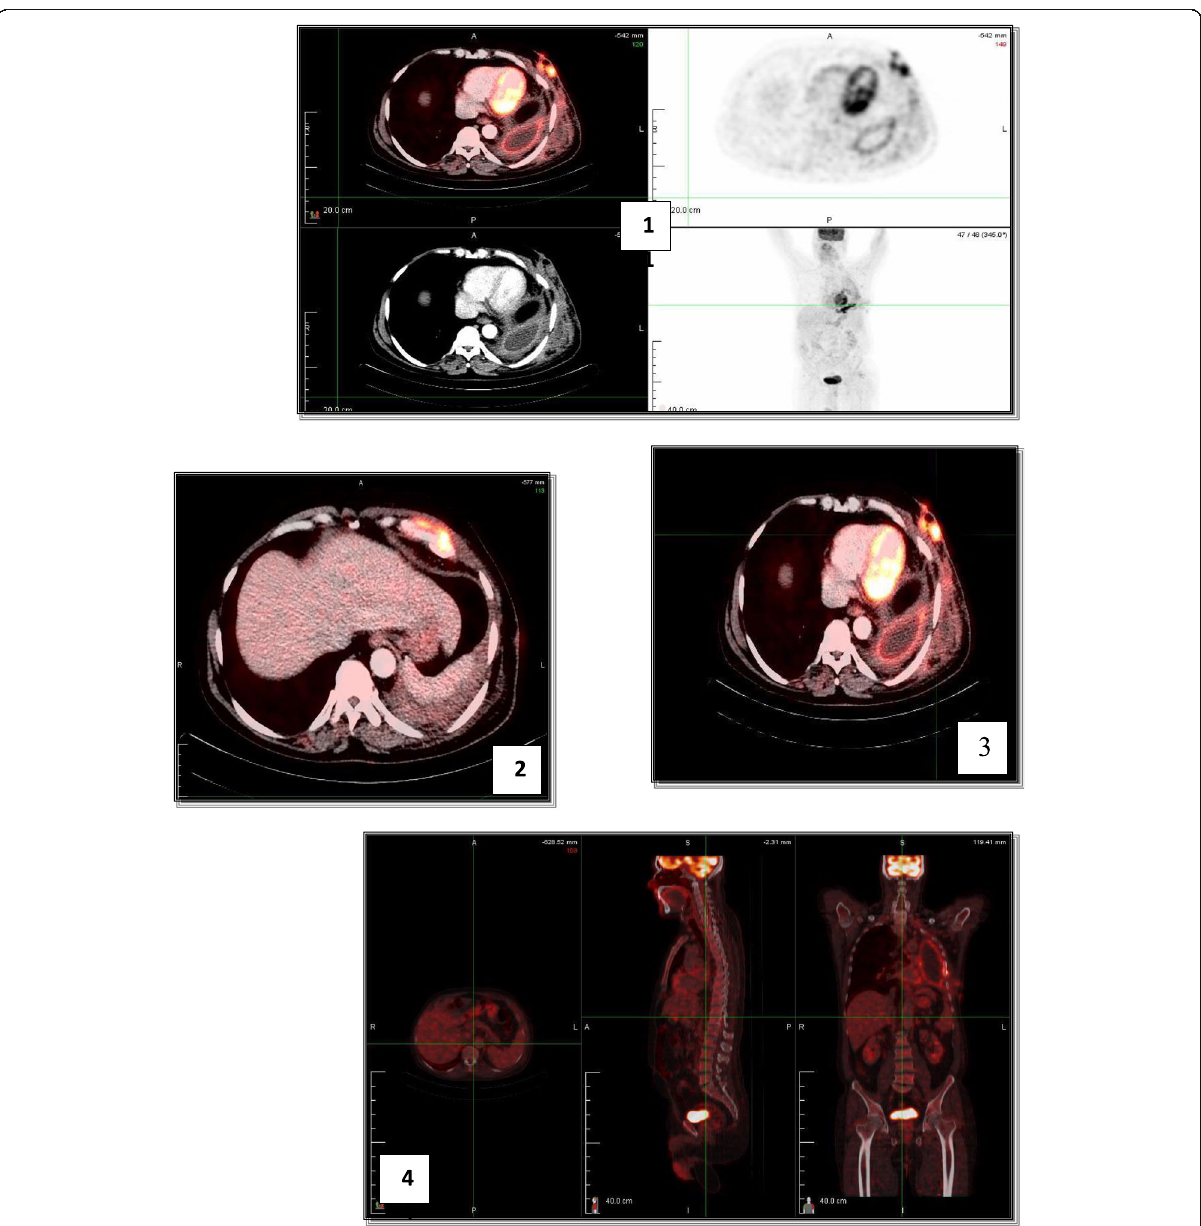
Fig. 2 1 Axial CT, PET, and PET/CT with MIP images showing FDG avid left anterior chest wall skin and subcutaneous lesions. 2 Axial PET/CT showing FDG avid left rib osteolytic lesion (ribs). 3 Axial PET/CT showing encysted hydro-thorax with peripheral activity of visceral and parietal pleura (lungs). 4 Axial, sagittal, and coronal PET/CT showing free other organs except for the skin, chest wall, and pleural FDG avid